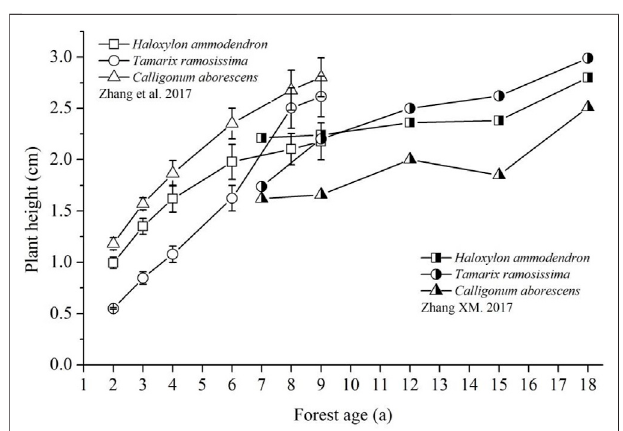
FIGURE 10 | Plant growth dynamics along the highway, reproduced from Zhang et al. (2016) and Zhang et al. (2017).